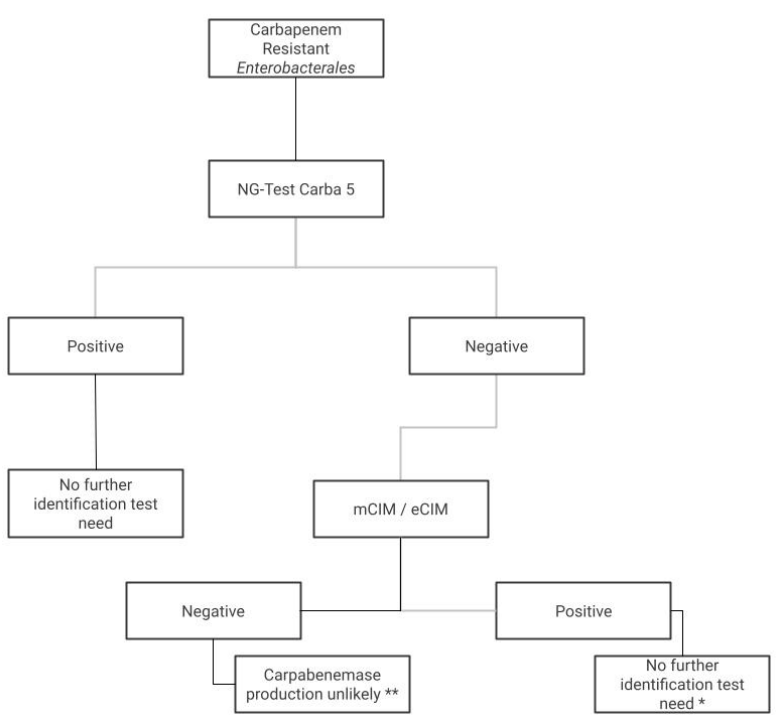
Figure 2. Algorithm for CRE detection. *We don’t recommend further testing in a routine laboratory that does not have PCR assays or genome sequencing; instead, we recommend contacting the central state laboratory. ** The mCIM test has a NPV close to 100%; in case of a negative test, the carbapenemase production seems to be unlikely and these strains must be investigated for another carbapenem ‐ resistance mechanism like hyper AMP ‐ c production.